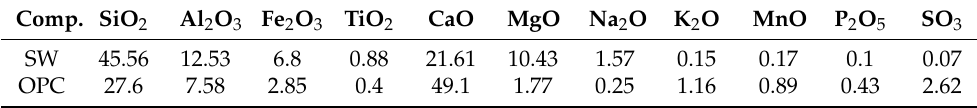
Table 3. Chemical composition of the SW and the OPC (%) by X-Ray Fluorescence. Comp. SiO